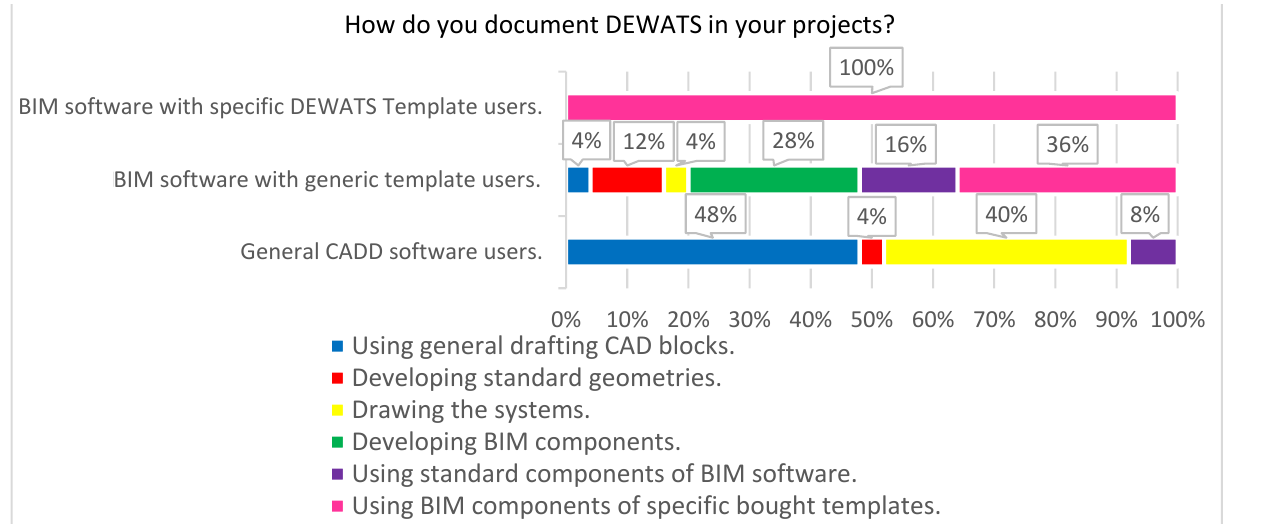
Figure 5. Answers to the third question. Source: authors (2020).